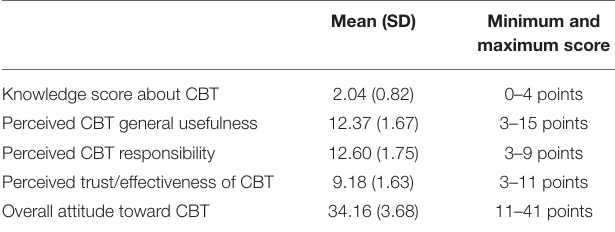
TABLE 3 | Descriptive statistics for the measured knowledge and attitudes of respondents of the people toward CBT ( N = 464). Mean